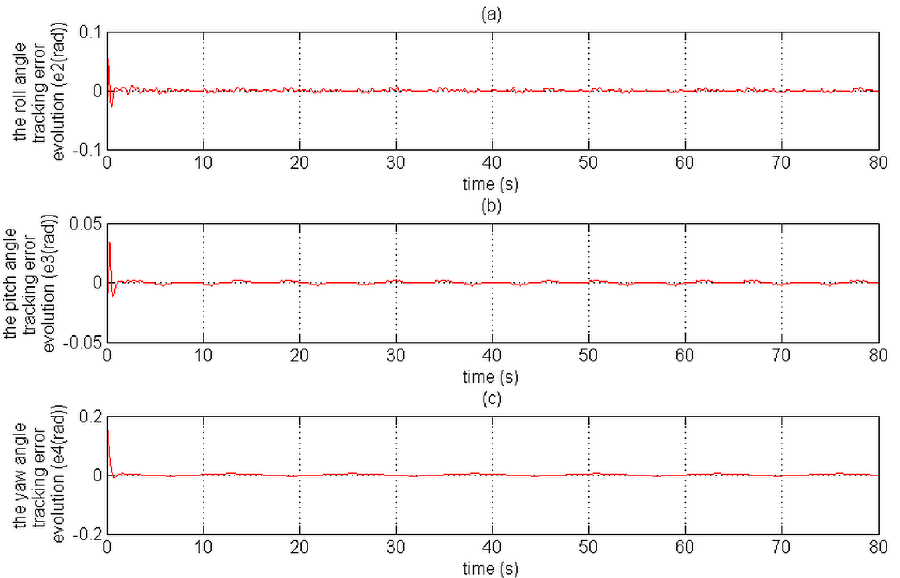
Figure 17. The attitude tracking errors obtained by the PTCM: ( a ) roll angle error e 2 ( rad ) ; ( b ) pitch angle error e 3 ( rad ) ; ( c ) yaw angle error e 4 ( rad ) .